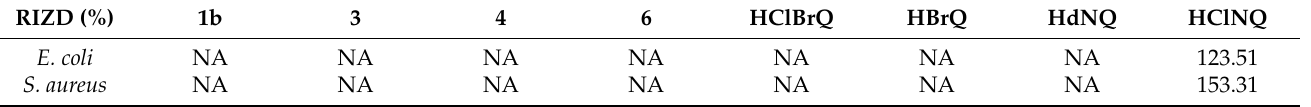
Table 4. Antibacterial activity of tested complexes. RIZD (%) means percentage of relative inhibition zone diameter. All complexes were tested against E. coli and S. aureus in 3 replicates (n = 3, ± SD).